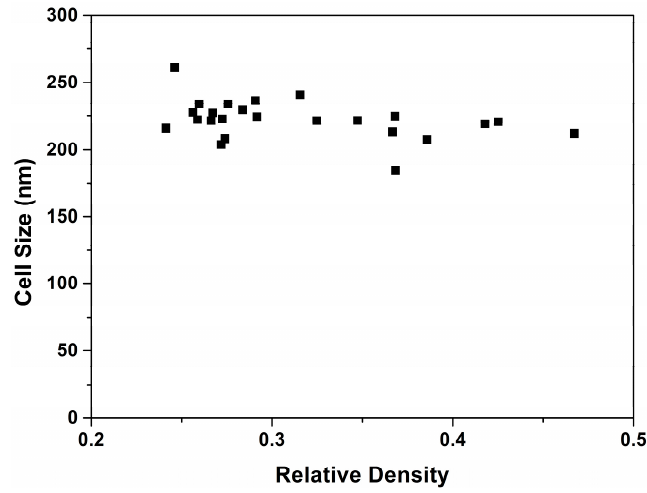
Figure 6. Average cell size as a function of relative density.